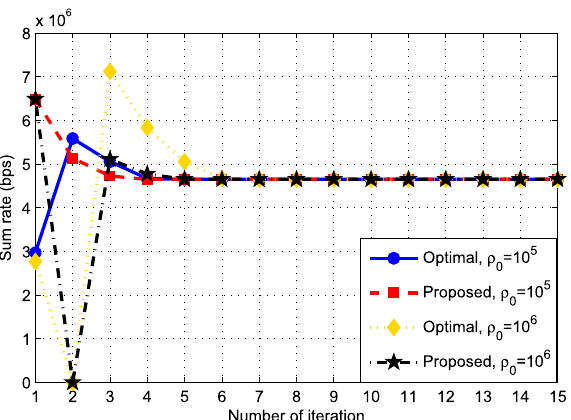
Fig. 5 Sum rate of optimal and proposed algorithms for data transmission versus number of iteration